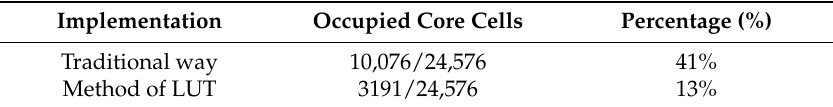
Table 4. Resource consumption using the field-programmable gate array (FPGA) in the traditional method and the look-up-table (LUT) method.